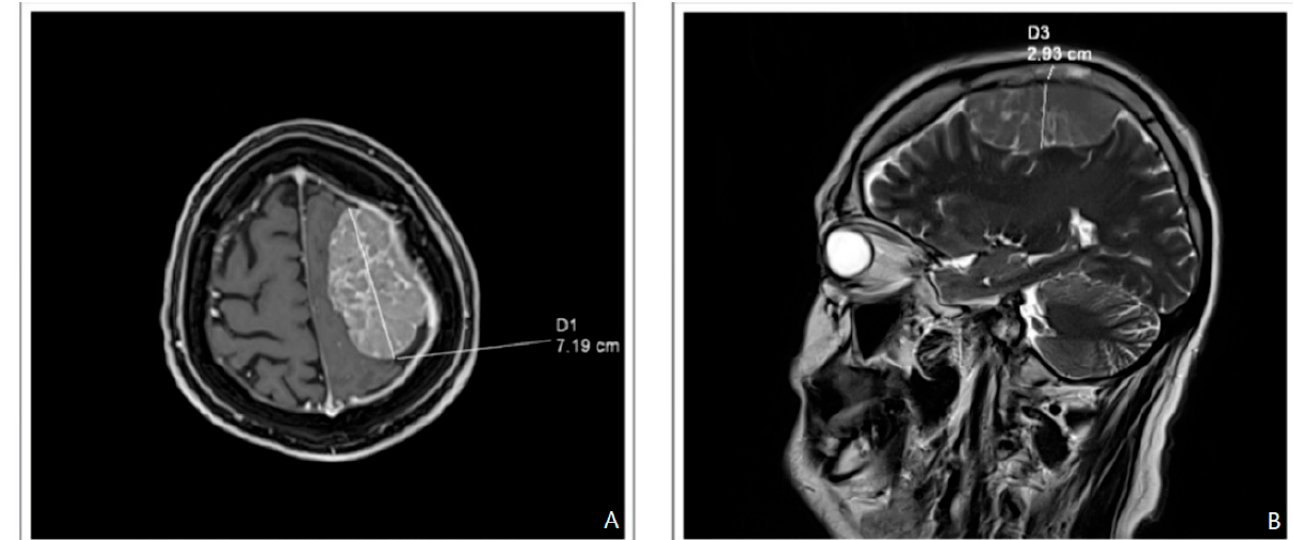
Figure 1. Magnetic resonance imaging ( A ) T1 with contrast, axial view, and ( B ) T2, sagi tt al view.